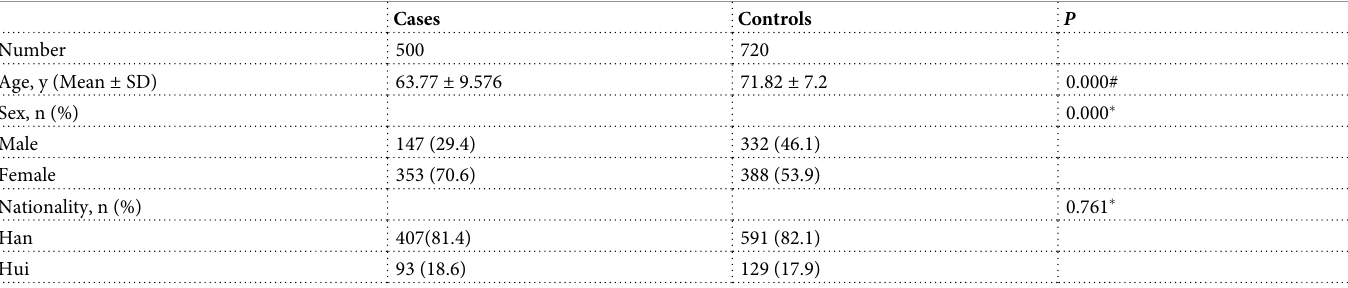
Table 1. Demographic characteristics of PACG cases and